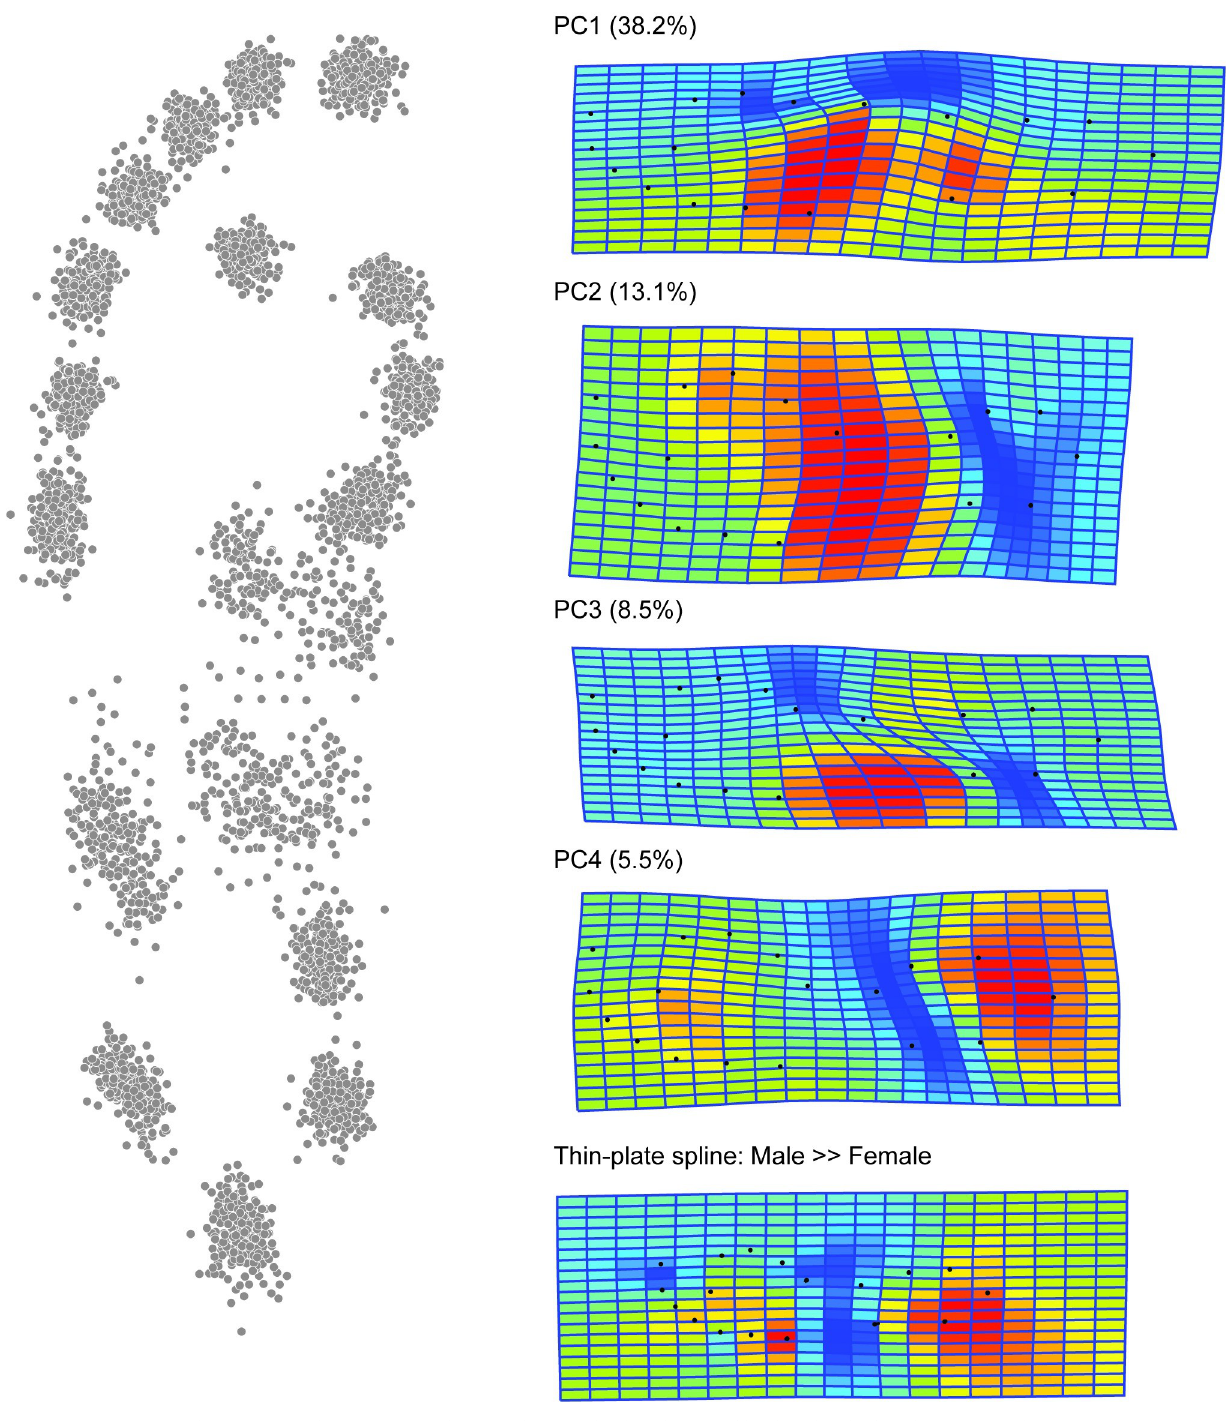
Fig 5. Geometric morphometrics on the Bournemouth-Data, showing the distribution of landmarks, the first four Principal Component Warps (65.3% of the variance) and thin-plate spline comparison of the male to female means. N = 132 males and 165 females.